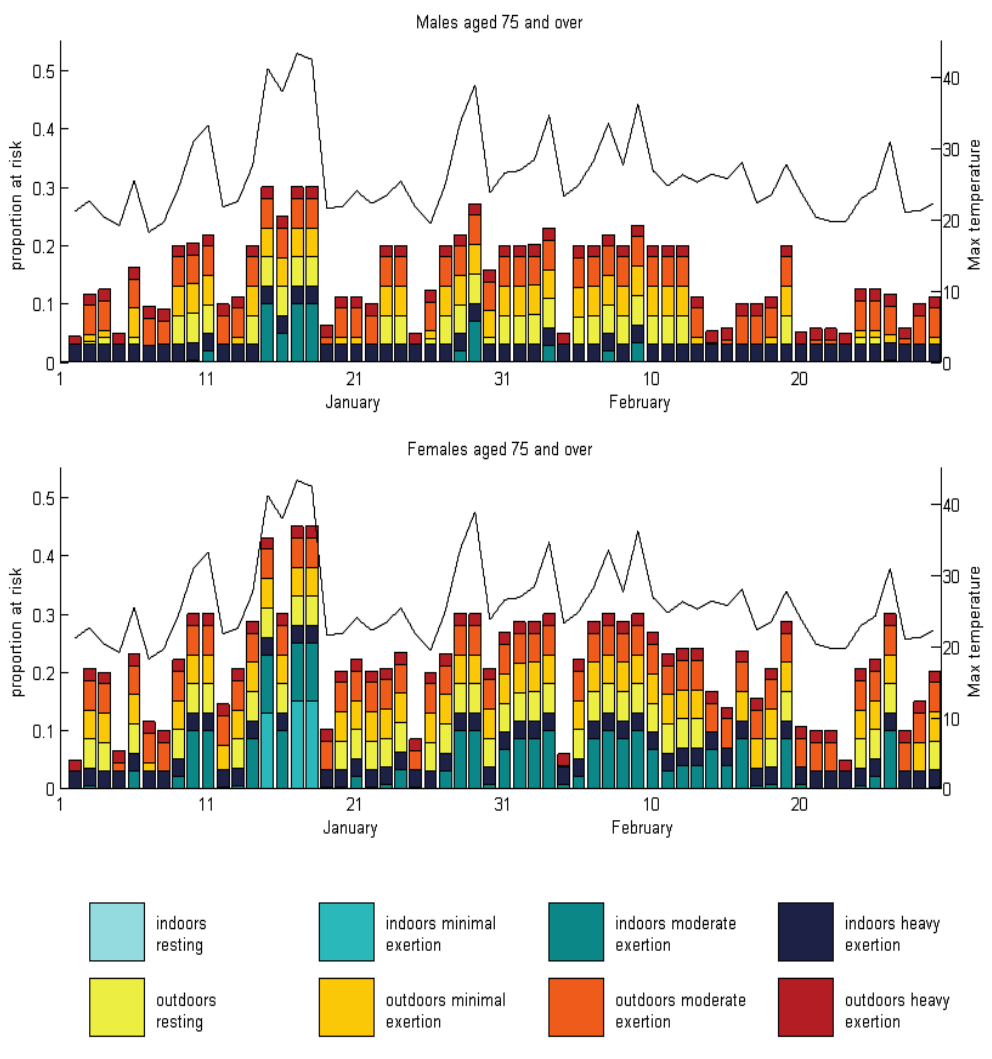
Figure 4. The proportion of individuals aged 75 and over that gain more than 2 °C in one hour at 3:00 p.m. on each day in January and February 2014 in Melbourne, Australia, assuming no modification to behavior. Individuals are categorized by indoor or outdoor exposure, and by their level of exertion. Daily maximum temperature is also shown on each graph (black lines, right hand